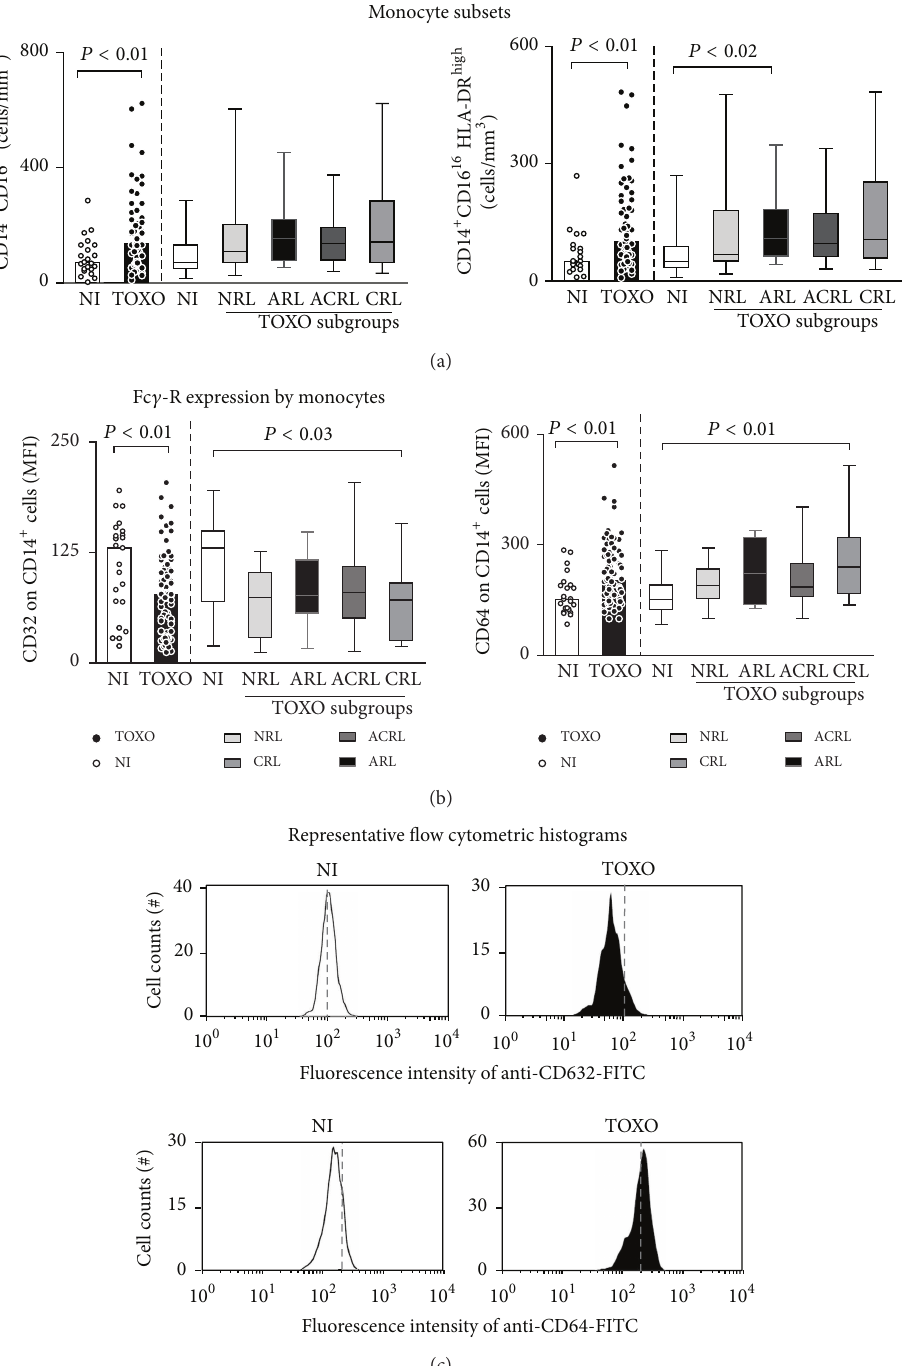
Figure 1: Monocyte subsets (a) and FC 𝛾 -R expression profile of monocytes (b) in the peripheral blood of congenital toxoplasmosis infants (TOXO) and noninfected controls (NI). Congenital toxoplasmosis was further categorized according to the clinical ocular status, referred to as no retinochoroidal lesions (NRL), active retinochoroidal lesions (ARL), active/cicatricial retinochoroidal lesions (ACRL), and cicatricial retinochoroidal lesions (CRL). The results are expressed as scatter plots of individual values and the medians of absolute cell counts/mm 3 (left side)orinbox-plotformat(rightside),wheretheboxstretchesfromthelowerhinge(25thpercentile)totheupperhinge(75thpercentile),and the middle half represents the median of the distribution as a line across the box. Significant differences are highlighted by connecting lines, and 𝑃 values are shown in the figure. (c) Representative histograms illustrating the downregulation of CD32 (top panels) and the upregulation of CD64 (bottom panels) on circulating monocytes from infants with congenital toxoplasmosis (black) compared to noninfected controls (white). The dashed lines were set to highlight the shift in the histogram distribution toward lower or higher FC 𝛾 -R expression by